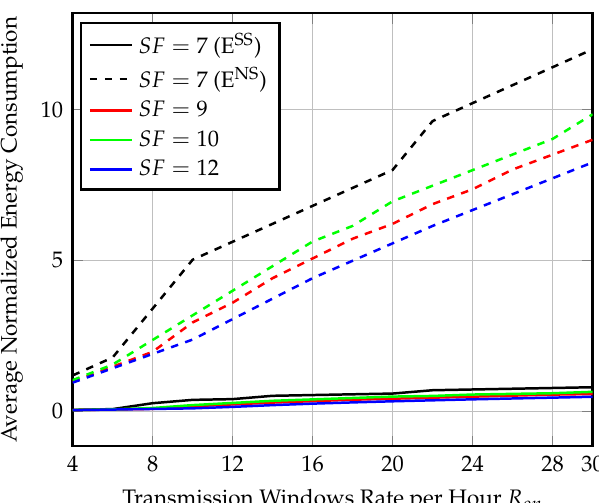
Figure 14. Average normalized energy consumption for different SF and R on values at speed = 80 km/h and single gateway for nonsynchronized gateway arrival